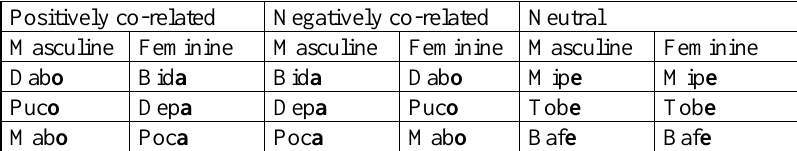
Table 4. Pseudo-nouns as a function of phonology-gender